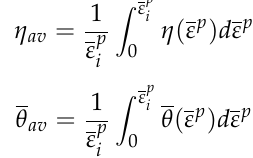
Figure 7. Comparison between experimental and simulation results of 304L stainless steel: ( a ) NT05 specimen, ( b ) NT10 specimen, ( c ) NT15 specimen, and ( d ) CH03 specimen. The flow stress using the Voce equation showed a strength drop before reaching the maximum strength. The flow stress calculation using the Swift equation is most appropriate.